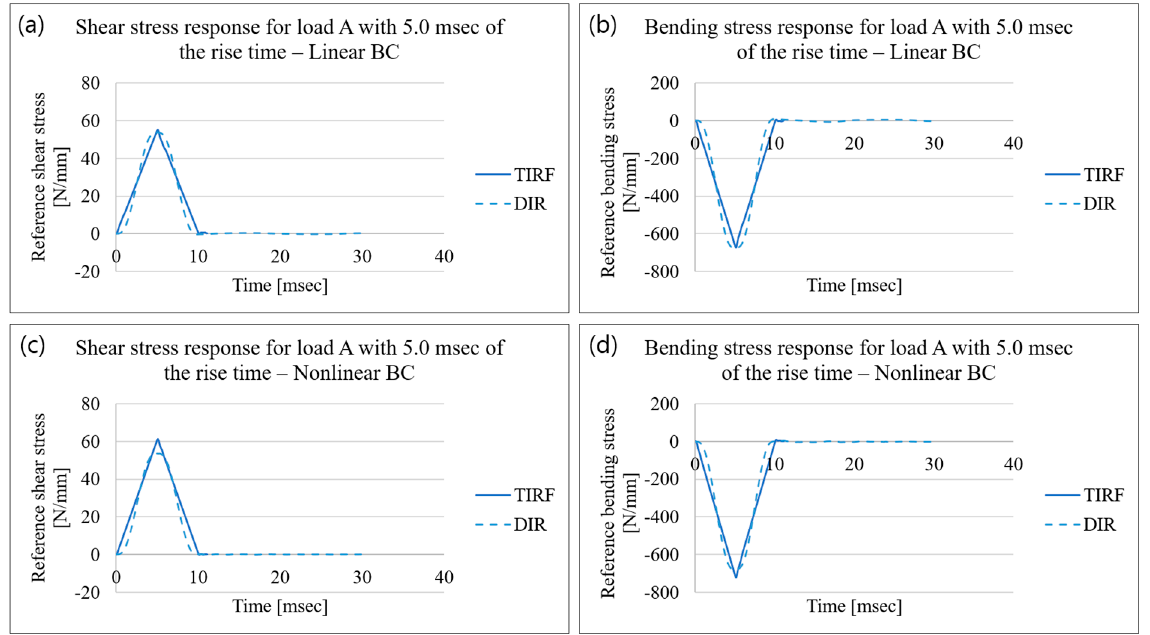
Figure 19. Reference shear and bending responses for Load J (3 × 1 load case) using TIRF and DIR for impact pressure of 5.0 ms of rise time: ( a ) Reference shear responses with linear boundary conditions, ( b ) Reference bending responses with linear boundary conditions, ( c ) Reference shear responses with nonlinear boundary conditions, and ( d ) Reference bending responses with nonlinear boundary conditions.